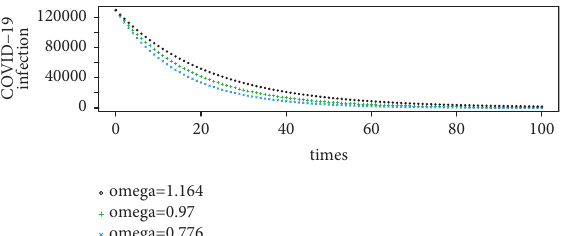
Figure 5: Simulation of COVID-19 infection at different contact rates ( ω ) between the susceptible and infected individuals. As ω increases from 0.776 to 1.164, there is a rightward shift in COVID-19 infection.